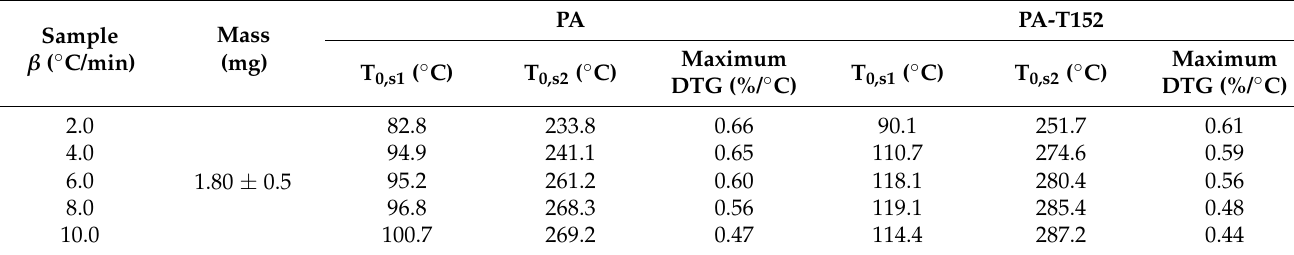
Table 1. Thermogravimetric loss data for PA and